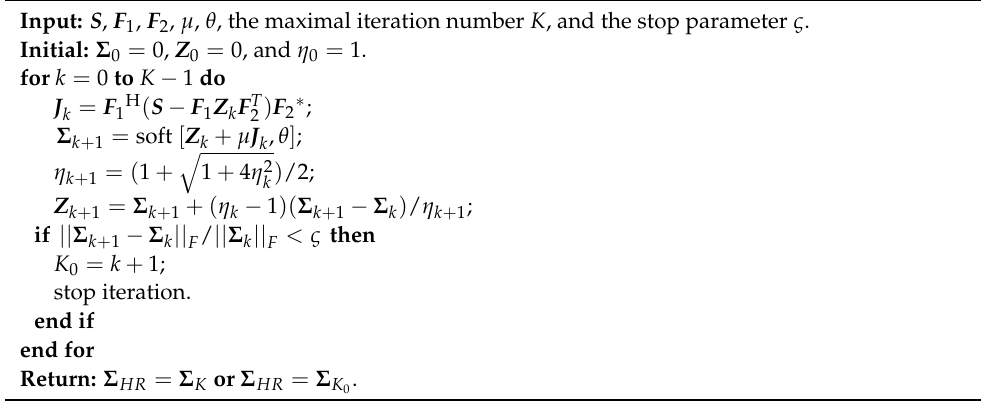
Algorithm 1 The proposed high-resolution imaging algorithm based on 2D